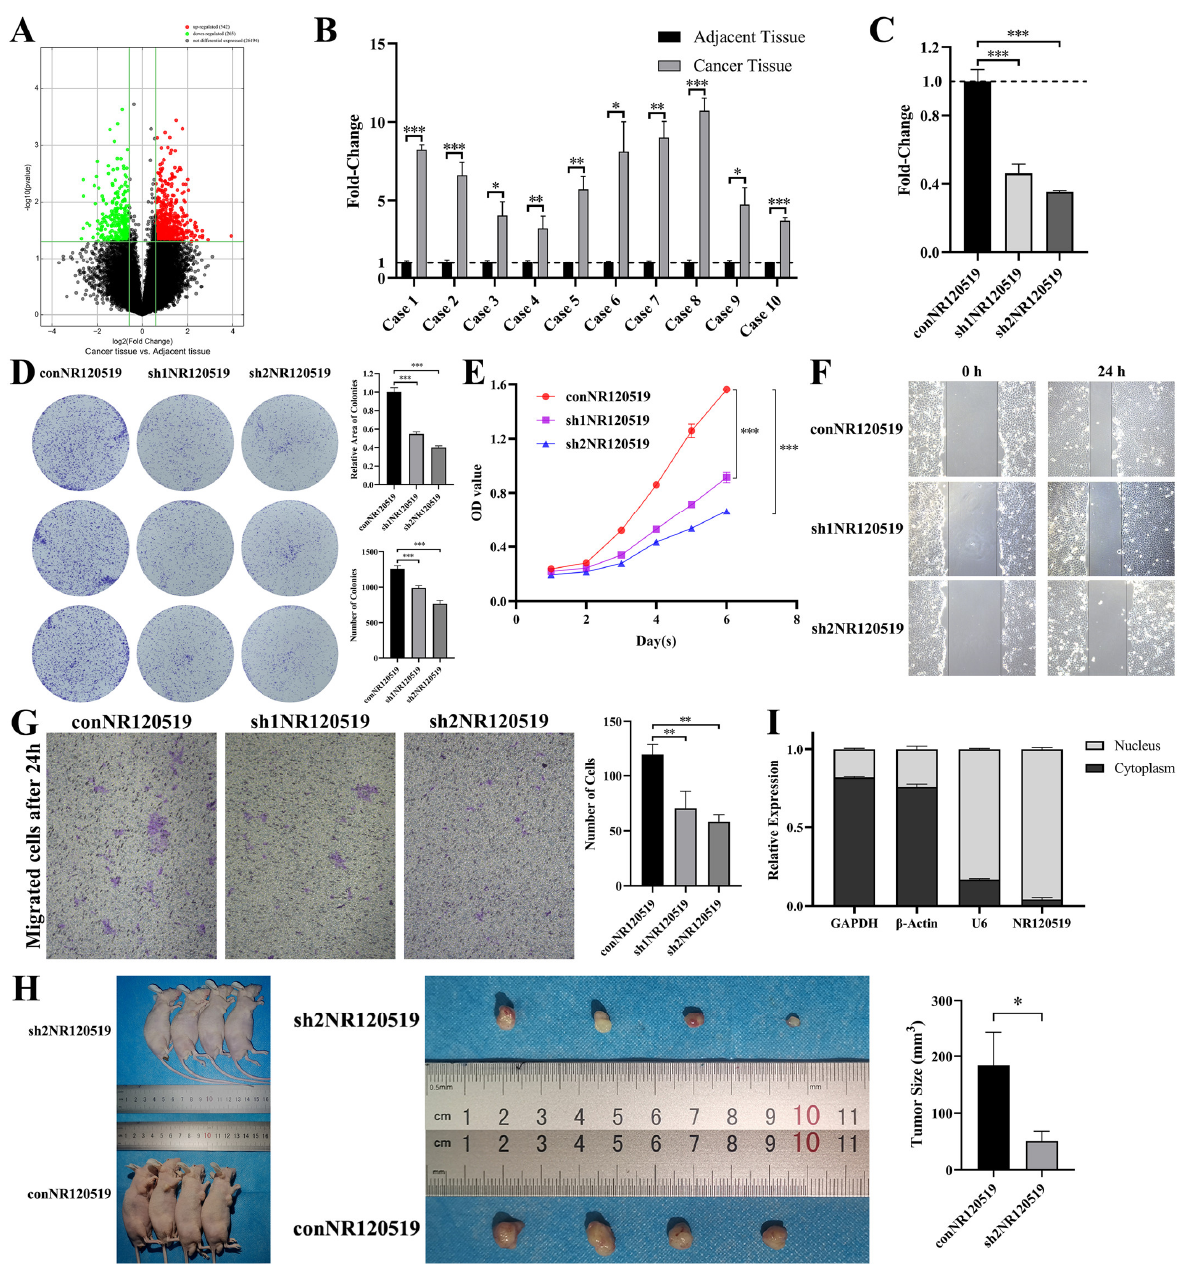
Figure 1. NR120519 was upregulated in hypopharyngeal carcinoma tissues and played a pro-car- cinogenic role. ( A ) Volcano plots of differentially expressed lncRNAs in hypopharyngeal carcinoma and paraneoplastic tissues. ( B ) Relative expression of NR120519 in 10 pairs of hypopharyngeal car- cinoma and paraneoplastic tissues. ( C ) Knockdown efficiency of two NR120519 targets (sh1NR120519 and sh2NR120519). ( D ) Colony formation assay involving NR120519 control and two knockdown groups. The cells were cocultured in 6-well plates. ( E ) CCK-8 experiments involving NR120519 control and two knockdown groups. ( F ) Wound healing experiments involving NR120519 control and two knockdown groups under ×10 magnification. ( G ) Transwell experiments involving NR120519 control group and two knockdown groups under ×10 magnification. ( H ) Tu- morigenesis experiment in nude mice involving NR120519 control and knockdown (sh2NR120519) groups. (I) Relative expression of NR120519 in the cytoplasm and nucleus. * p < 0.05; ** p < 0.01; *** p < 0.001.